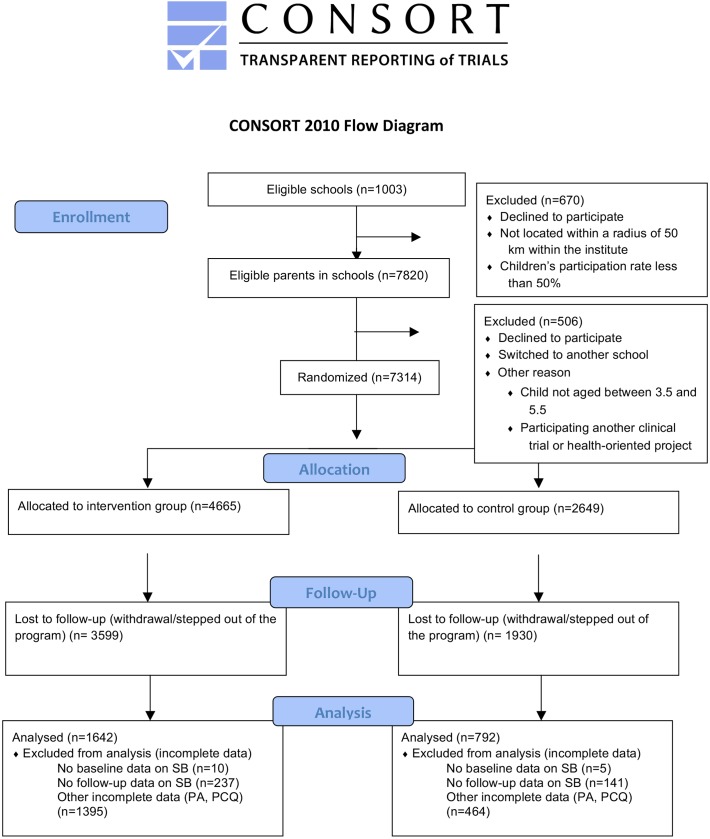
CONSORT Flow Diagram.